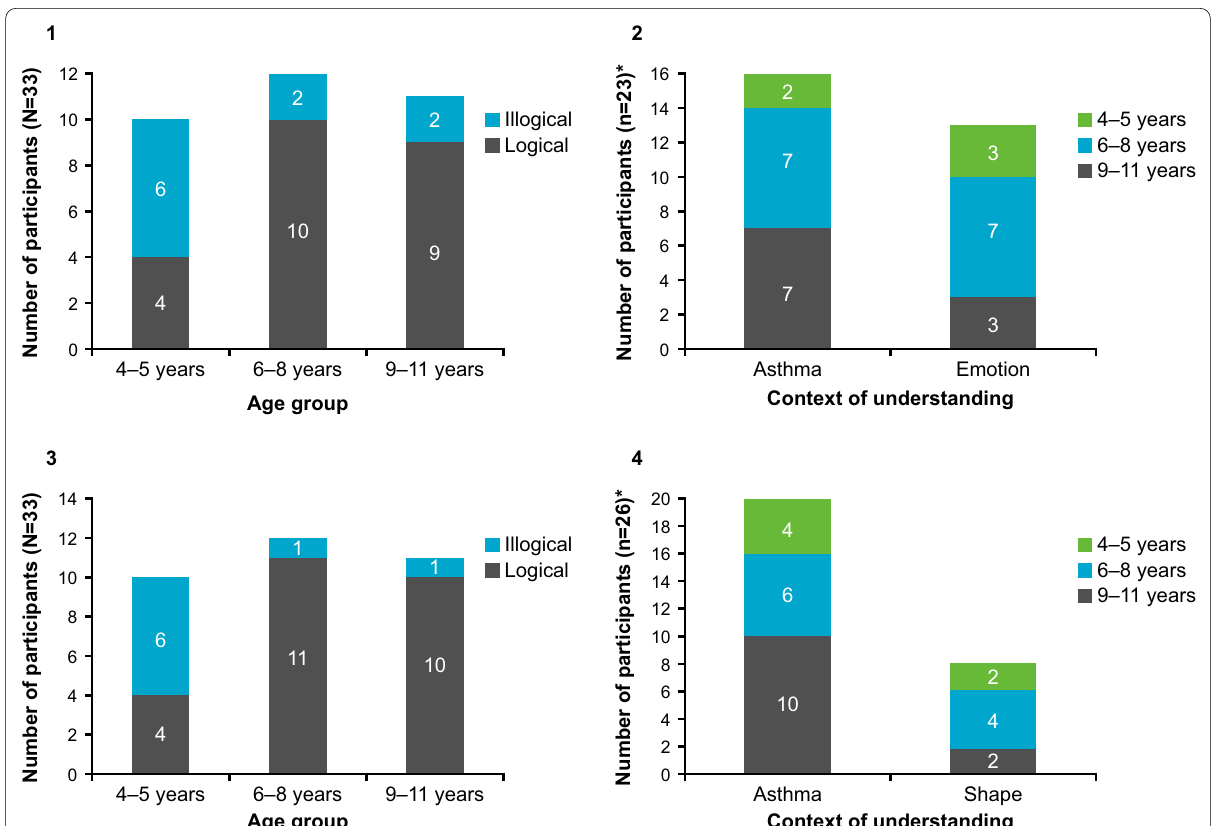
Fig. 6 Stage 2 logical and illogical ranking, scale understanding, and context of understanding. 1 Modified scale A (logical and illogical ranking); 2 Modified scale A (context of understanding); 3 Scale B (logical and illogical ranking); 4 Scale B (context of understanding). Logical and illogical ranking: represents the number of children who ranked the options in a logical sequence. Context of understanding: for modified scale A conveyed understanding both in the context of asthma and the emotions portrayed by the image; for scale B conveyed their understanding in the context of their asthma and the shape of the images. *Children conveyed understanding both in the context of asthma and emotions (six and two in 6.2 and 6.4,